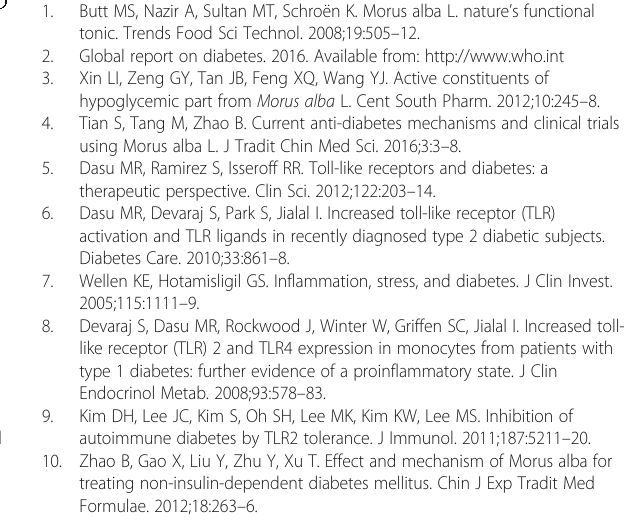
muscle. Table S7 and the original western blots Effect of WEM treatment on protein expression TLR1, TLR2, and the downstream transcription factors' expression. Table S8. The gene expression of IRS1 and InsR affected by WEM in adipose tissue. Table S9 and the original western blots Protein expression of IRS1 and InsR influenced by WEM in adipose tissue of diabetic mice. Abbreviations AMPK: AMP-activated protein kinase; DM: Diabetes mellitus; DNJ: 1- dexoynojirimycin; HOMA-IR: Homeostasis model assessment of insulin